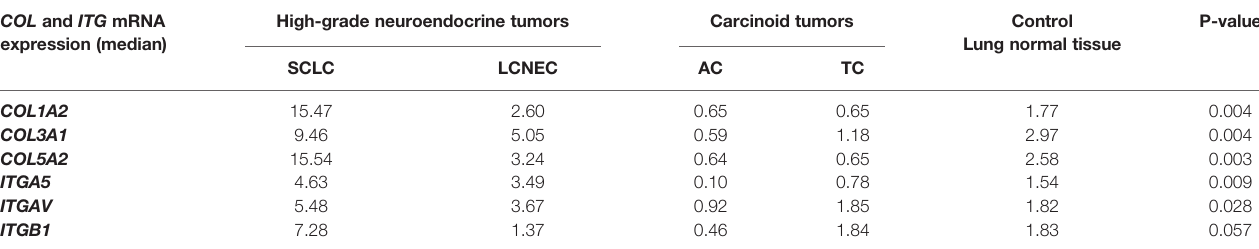
TABLE 2 | Association between gene expression of COL and ITG and PNENs histological types by non-parametric Kruskal-Wallis test (P<0.05). COL and ITG mRNA expression